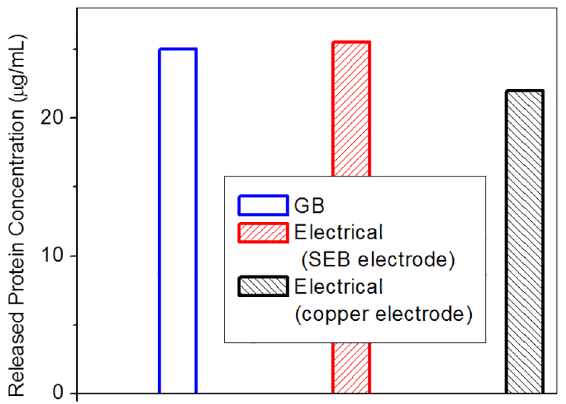
Figure 12. E-Lysis efficiency, with respect to protein release, in channels with SEB and copper electrodes. An electric field of 10 kV/cm was applied until a peak temperature near 100 u C was reached, followed by a constant temperature dwell with voltage feedback control. Both SEB and plain copper electrodes reach protein release concentrations similar to glass bead (GB) lysis.